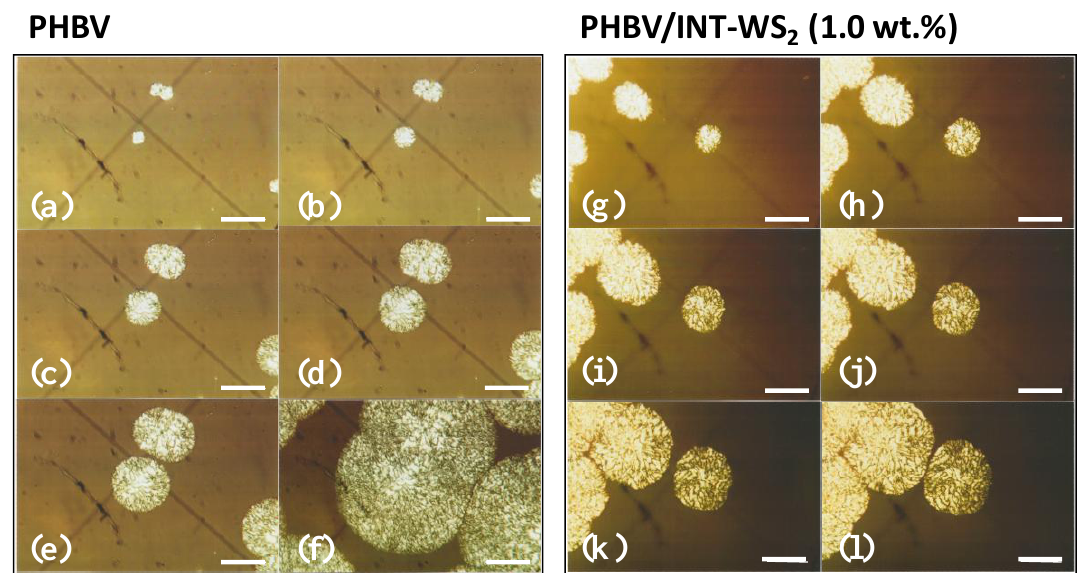
Figure 7. POM images of PHBV/INT-WS 2 nanocomposites. PHBV: ( a – f ) are images taken at 8 min; 12 min; 23 min; 30 min; 37 min and after 60 min rapidly cooled to 80 °C, respectively; and PHBV/INT-WS 2 (1.0 wt %): ( g – l ) are images taken at 4 min; 5 min; 6 min; 7 min, 8 min and 10 min, respectively. Scale bar 100 μm.